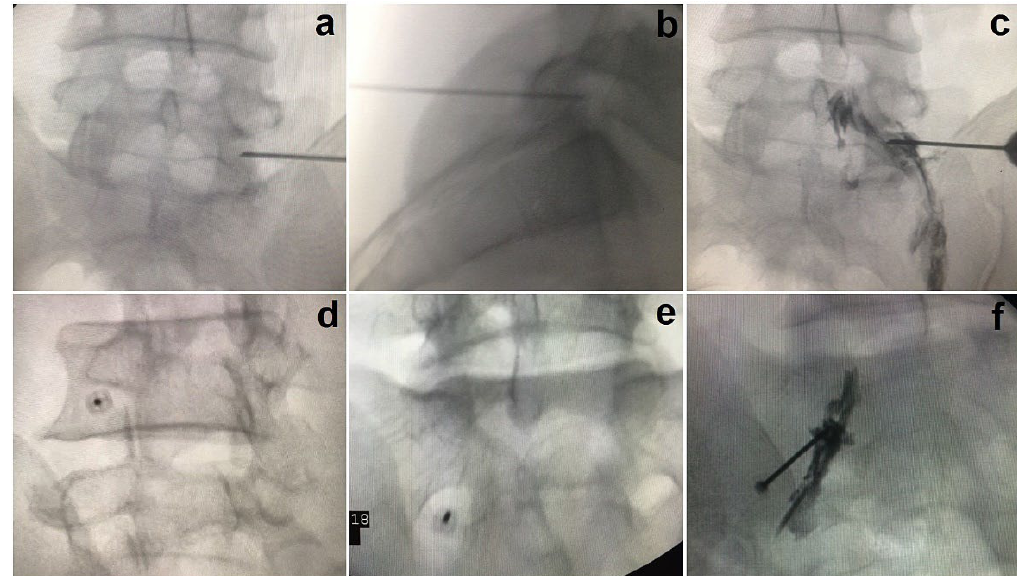
Figure 4. C-arm images during the SNRB procedure. ( a ) Antero-posterior (AP) view of needle placement during the AP approach, ( b ) Lateral view showing needle tip positioned in the foramen, ( c ) AP view following injection of Iohexol dye showing appropriate spread along the L5 nerve root, ( d ) Oblique view showing needle placement below the neck of the Scottie dog during the Scottie dog approach, ( e ) AP view of needle placement in the S1 foramen, ( f ) Spread of dye along the S1 nerve root.